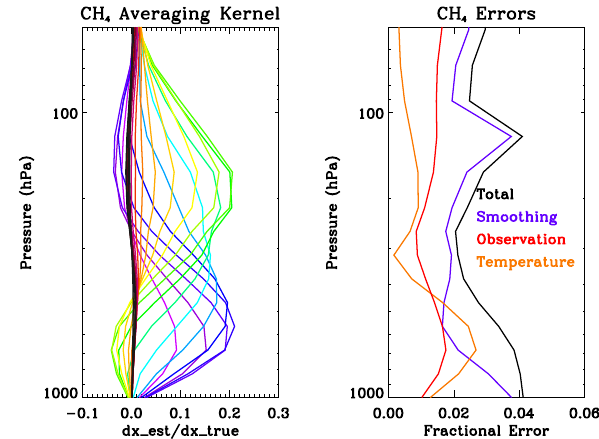
Fig. 2. (Left panel) Averaging kernels for TES estimate of CH 4 for tropical scene. Different colors help to distinguish pressures corre- sponding to each averaging kernel. (Right panel) Error distribution for TES CH 4 estimate for tropical scene. The observation error in- cludes uncertainties from noise and interferences such as H 2